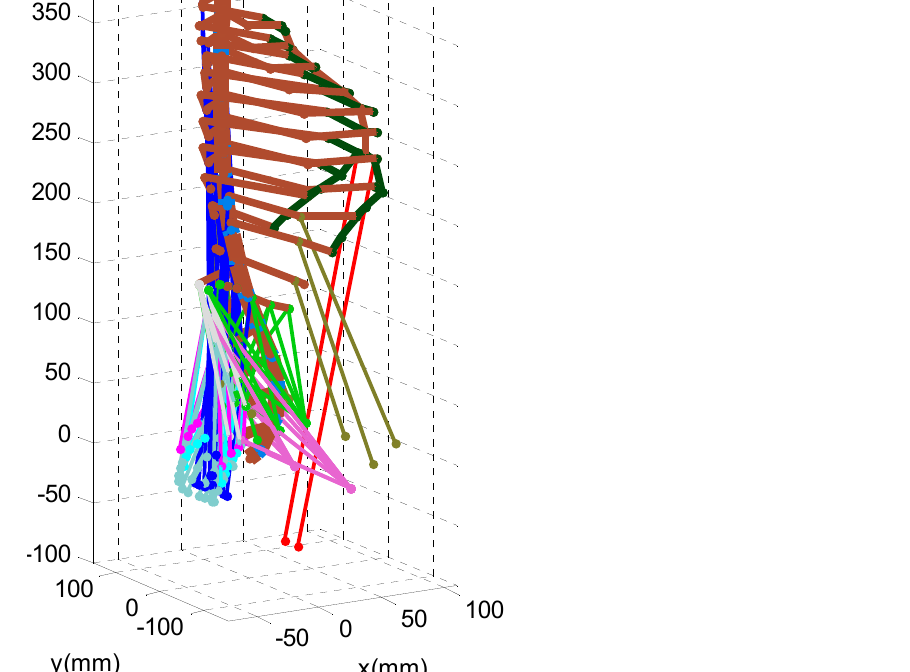
Figure 2. Trunk musculoskeletal model. Muscles of each group are with the same color. Bones are with brown color.